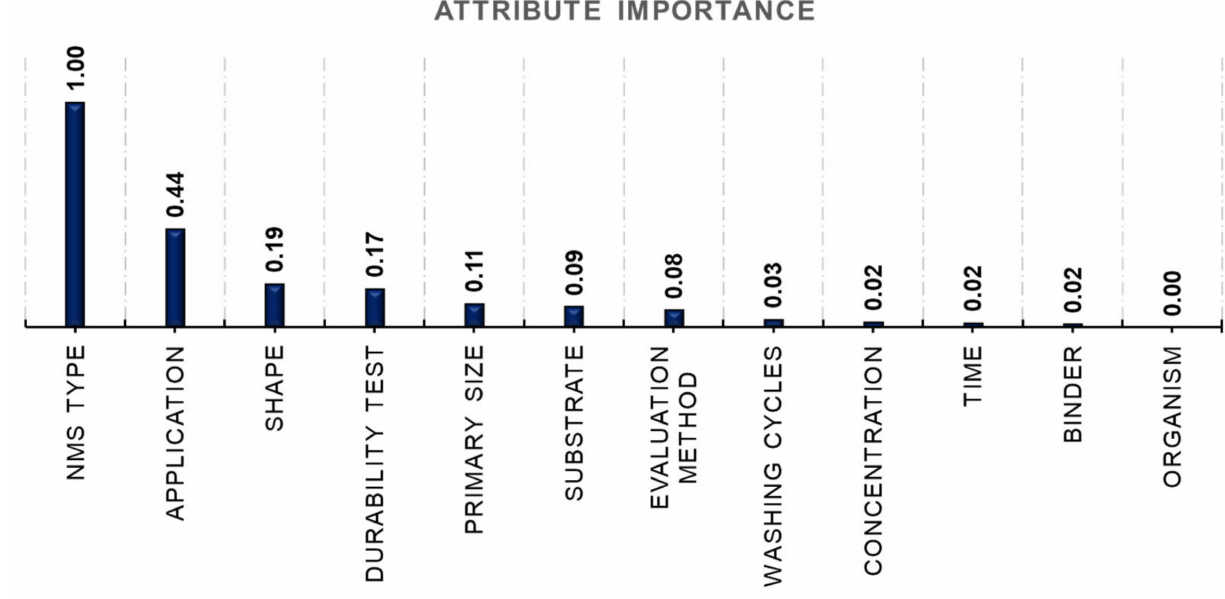
Figure 5. Attribute importance analysis by RF